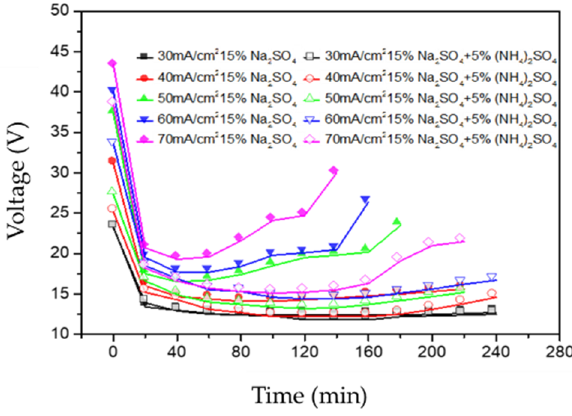
Figure 3. The voltage–time curves before and after adding (NH 4 ) 2 SO 4 with different current